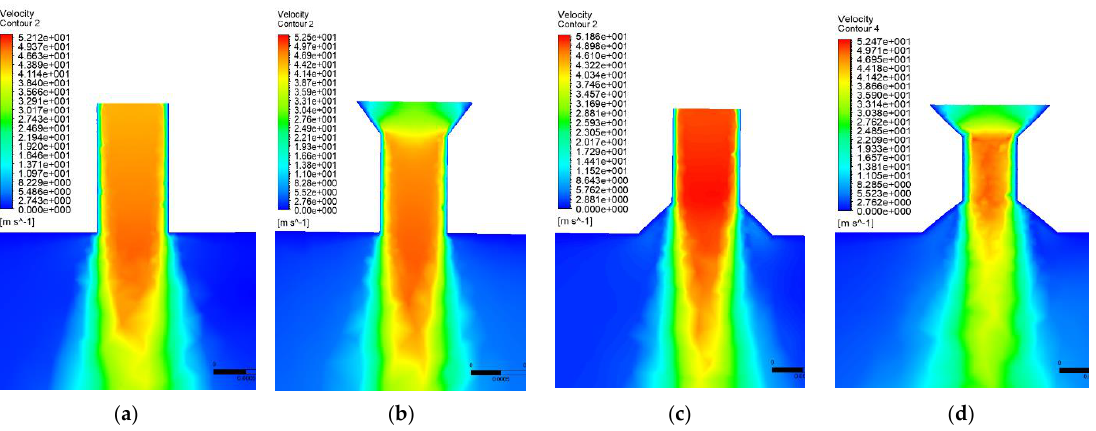
Figure 12. Velocity cloud image of the suction hole section. ( a ) Cylindrical-shaped suction hole; ( b ) Funnel-shaped suction hole; ( c ) Horn-shaped suction hole; ( d ) Diabolo-shaped suction hole.